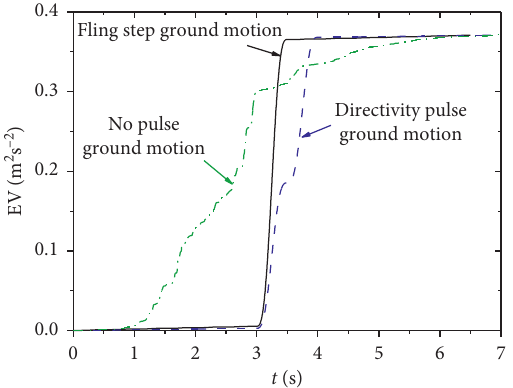
Figure 14: Velocity time history of measuring points above and below the